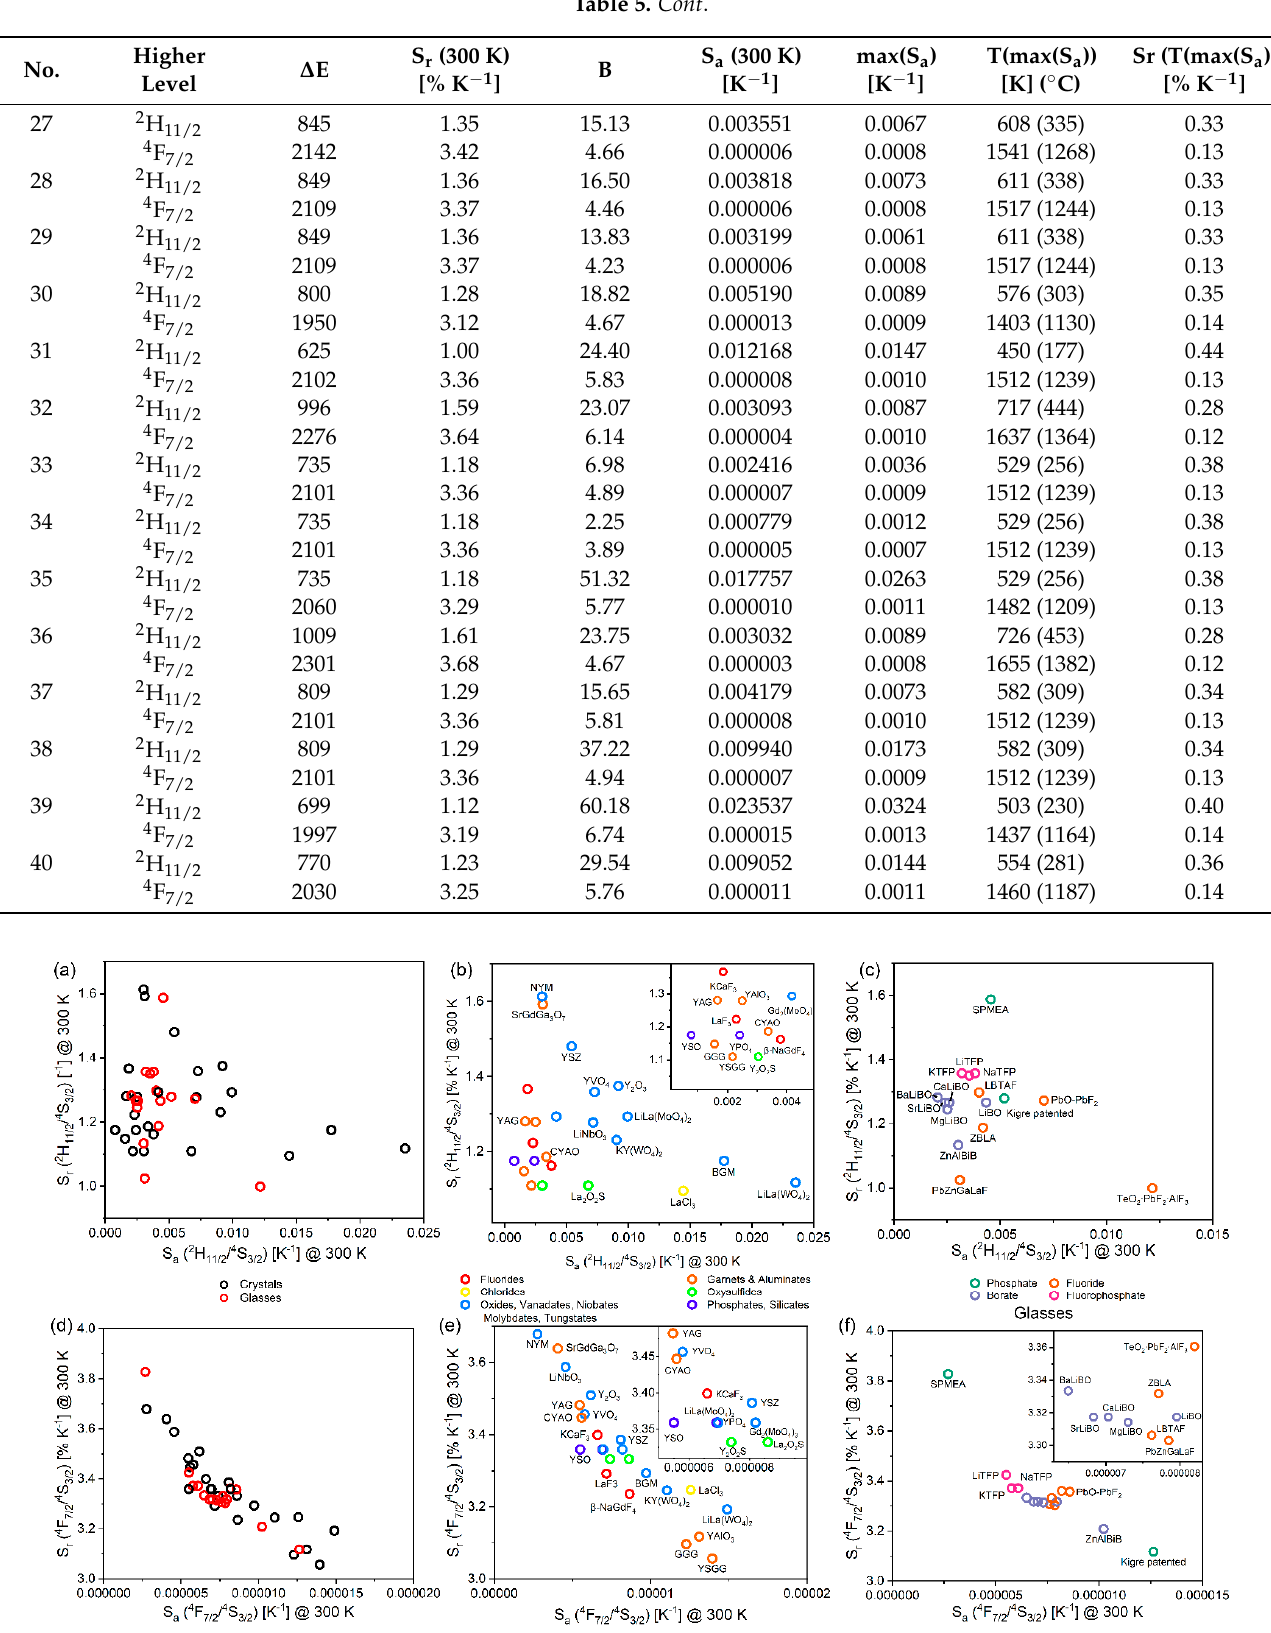
Figure 5. Relative sensitivities vs. absolute sensitivities at 300 K. (a–c) for LIR by 2 H 11/2 higher level, d–f by 4 F 7/2 . ( a ) and ( d ) comparison of crystals and glasses, ( b ) and ( e ) between crystal types, ( c ) and ( f ) between different glasses.